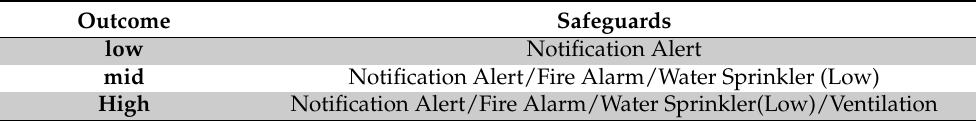
Table 8. Safeguard